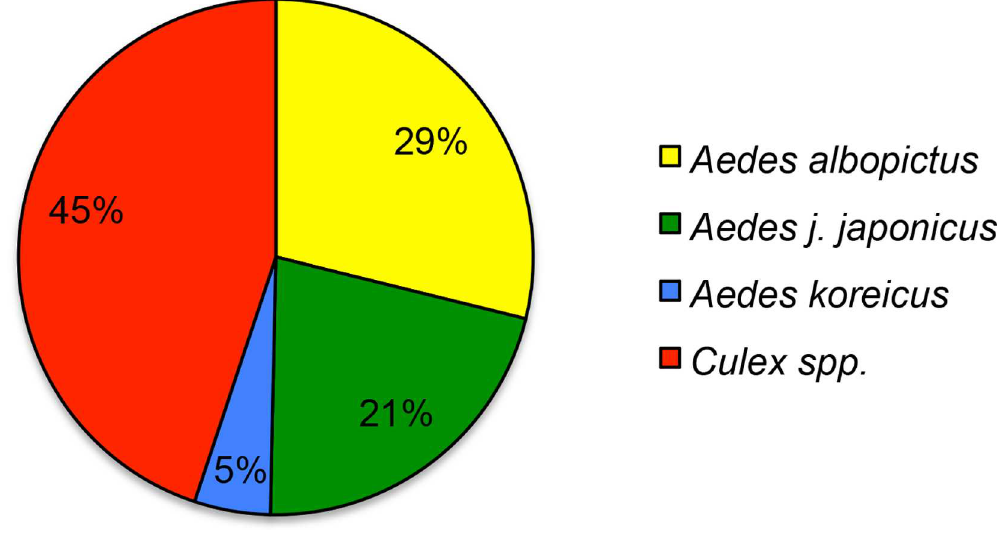
Fig 2. Diagram showingthe percentageof assigned Culicidaespeciesafterthe next-generation sequencingof 34 watersamplesand bioinformaticsequenceanalysesapplyinga 98% similarity threshold.